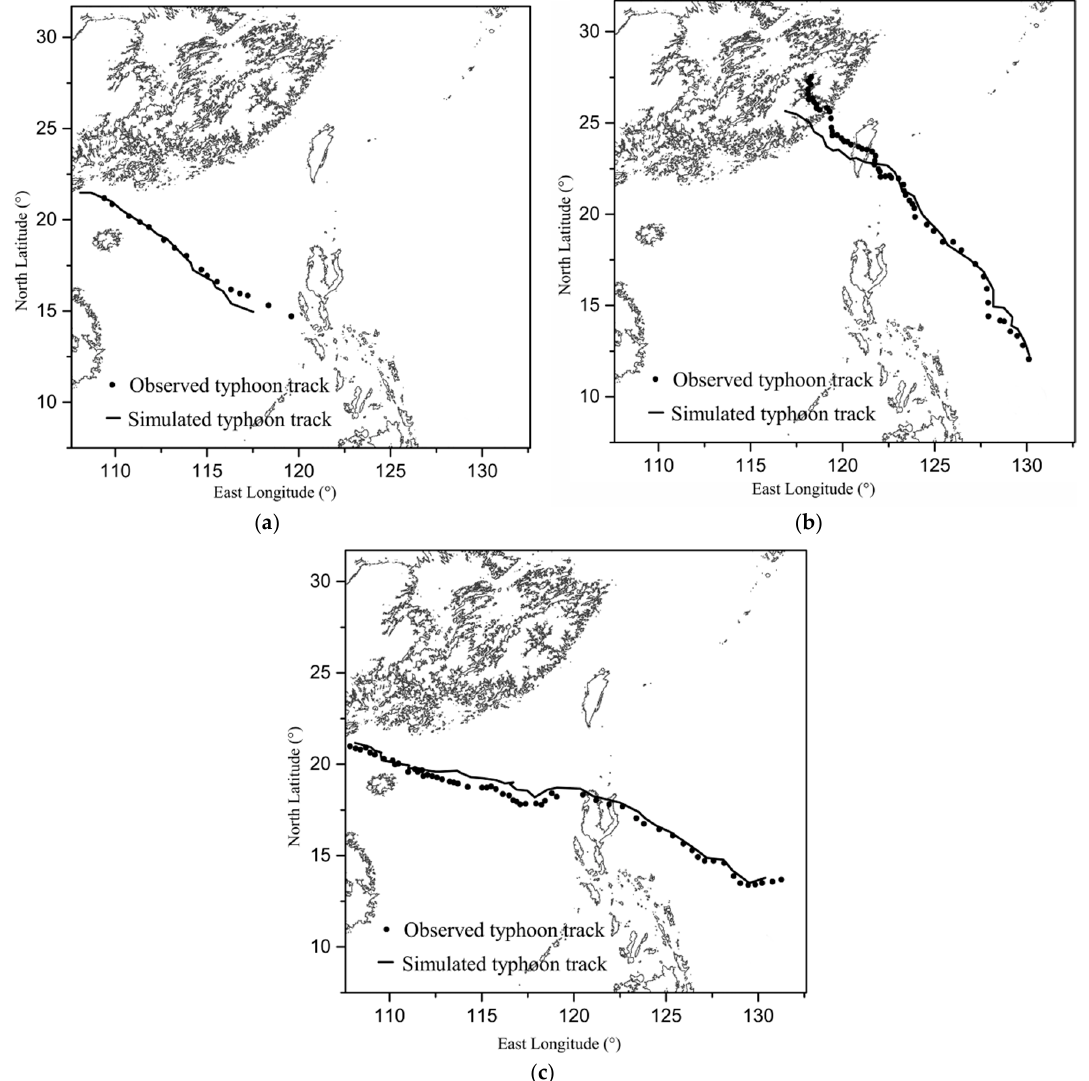
Figure 3. The comparisons of observed and simulated typhoon tracks: ( a ) Typhoon Rammasun; ( b ) Typhoon Matmo; and ( c ) Typhoon Kalmaegi.